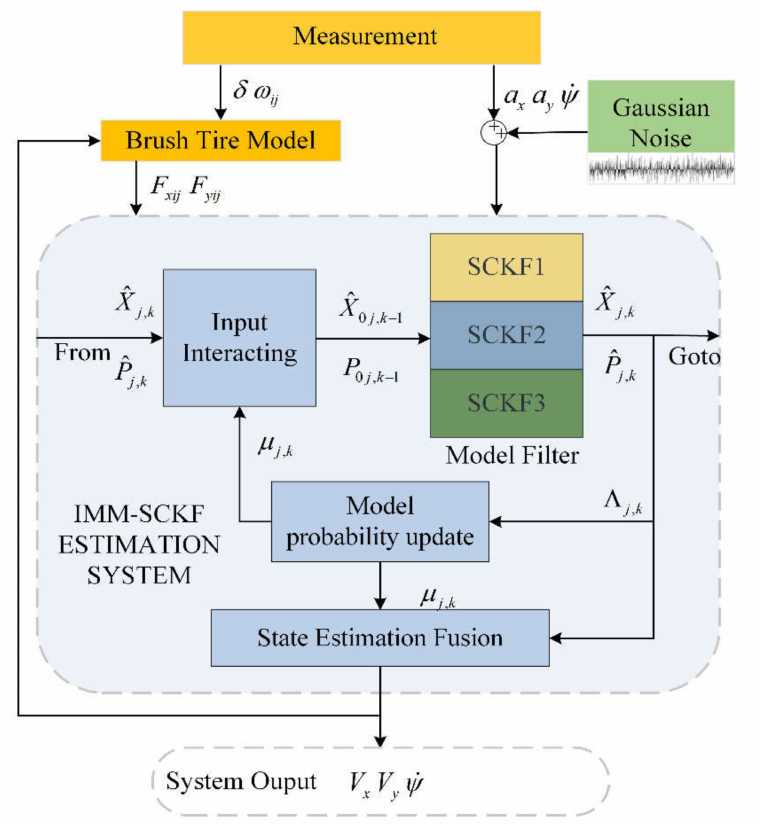
Figure 3. IMM-SCKF flow